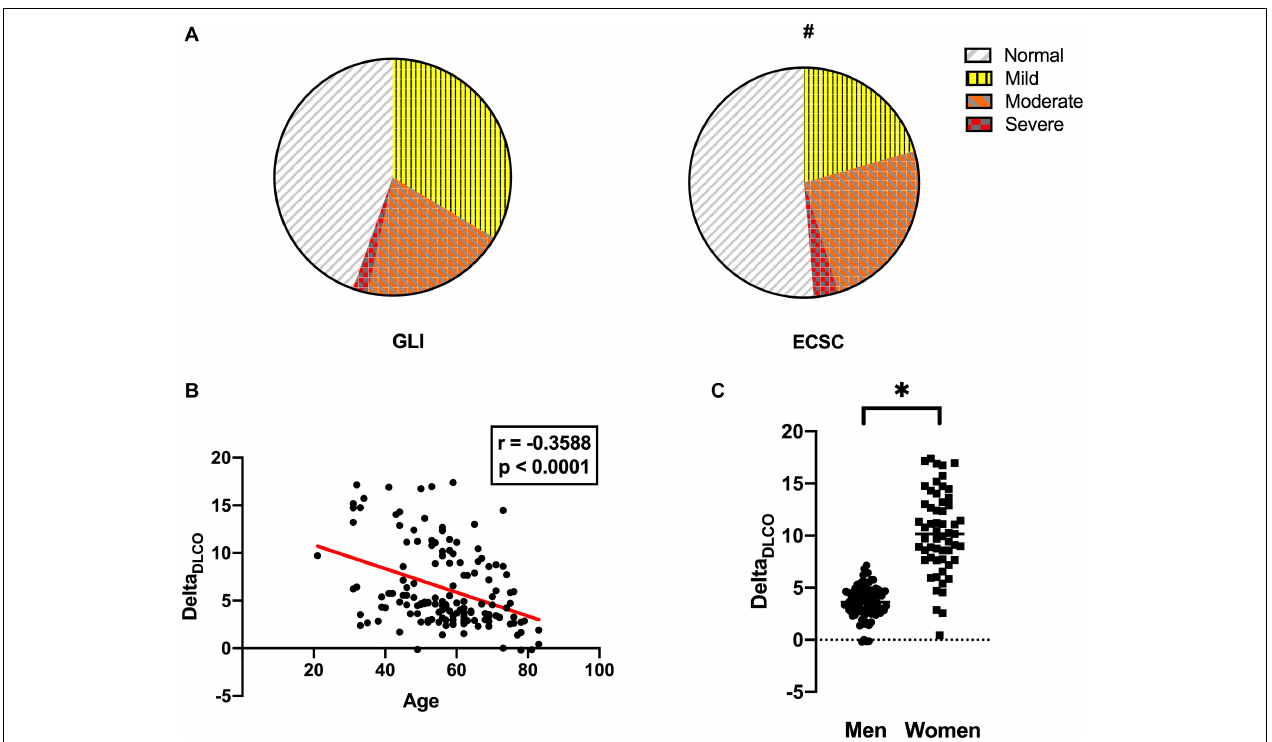
FIGURE 1 | Comparison between European Coal and Steel Community (ECSC) and Global Lung Function Initiative (GLI) reference equation in the diagnosis of diffusion capacity alteration. (A) Proportion of patients with normal D LCO , mild, moderate, or severe diffusion alteration according to GLI (left) or ECSC (right) reference equations; # p < 0.05 (Mann–Whitney). (B) Spearman correlation showing the effect of age on Delta DLCO ( D LCO % predGLI – D LCO % prcedECSC ). (C) Effect of sex on Delta DLCO ; ∗ p <